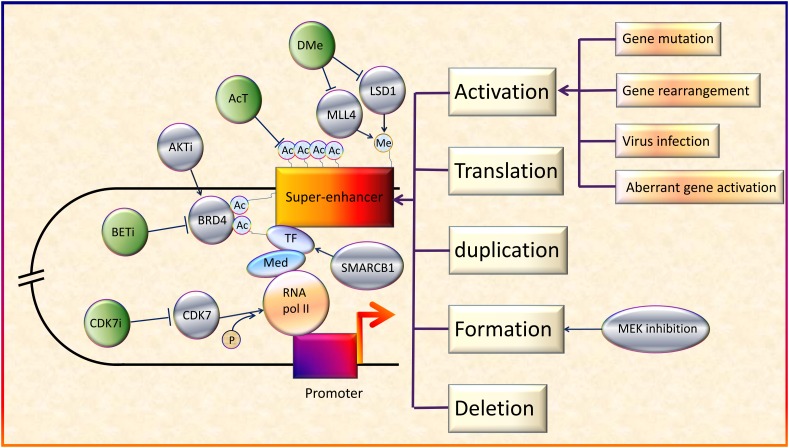
Regulation and therapeutic targets of SEs in cancers. On the whole, SEs can be activated by various genetic alterations including gene mutation, gene rearrangement, aberrant activation of genes and virus infection (Northcott et al., 2014; Kandaswamy et al., 2016; Chen et al., 2018; Dwight et al., 2018; Ott et al., 2018). In addition, activation, translation, duplication, formation, and deletion of SEs will also lead to abnormal transcription and cancer development (Xiang et al., 2014; Babu and Fullwood, 2017; Dave et al., 2017; Shen et al., 2017; Gong et al., 2018). Besides, acetyltransferase (AcT), like CREBBP/EP300, strengthens the function of BRD4 by promoting chromatin acetylation (Garcia-Carpizo et al., 2018). Demethylases (DMe), such as KDM5C, KDM6A, and lysine-specific demethylase 1 inhibitors (LSD1i), can suppress SEs via demethylation (Sugino et al., 2017; Andricovich et al., 2018; Chen et al., 2018). On the contrary, MLL4, a H3K4 methyltransferase, helps to maintain broad H3K4me3 and SEs (Dhar et al., 2018). SMARCB1, a core subunit of the SWI/SNF (BAF) chromatin-remodeling complex, helps stabilize TFs (Wang et al., 2017). MEK inhibition opens chromatin and establishes super-enhancers at genes required for late myogenic differentiation, through ERK2/MYOG pathways (Yohe et al., 2018). AKT inhibitors (AKTi) induce FOXO3a acetylation as well as BRD4 recognition (Liu et al., 2018). Although SEs generally upregulate oncogene expression, in some cases, they also promote the expression of tumor suppressor genes (Pelish et al., 2015).